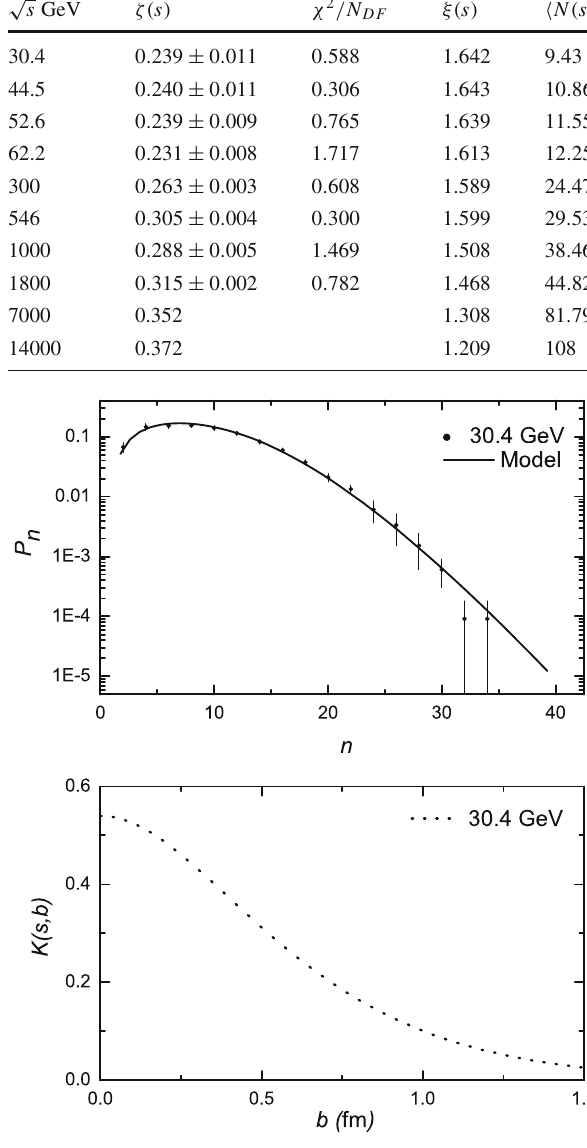
Fig. 1 Top panel: Comparison of the theoretical, Eqs. (15) and (16), and experimental results in full phase space P n ( s ) at 30.4 GeV. Data points from [14]. The another panel shows prediction of K ( s ) , Eq. (28), by using the parameters obtained from P n ( s ) analysis done in [19] This procedure in fact does provided an excellent description of the P n ( s ) data at high multiplicities, avoiding the intro- duction of more free parameters. The P n ( s ) plots from Ref. [19] are reproduced in this work, as shown at the top panels in Figs. 1, 2, 3, 4, 5, 6, 7 and 8. All the P n ( s ) results are in good agreement with the experimental points [14–16], the values of χ 2 / N DF are presented in Table 1. Theoretical predictions √ s = 7 and in full phase space P n ( s ) at the LHC energies of 14 TeV are shown in Fig.